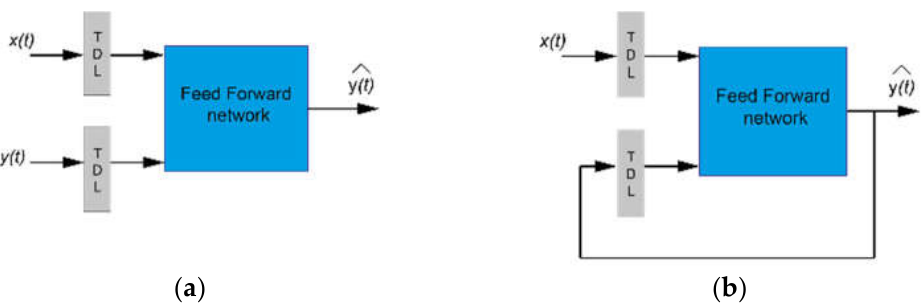
Figure 16. ( a ) Narx model implemented with feed-forward neural network to approximate the function f . ( b ) Parallel configuration for multi-step-ahead prediction.